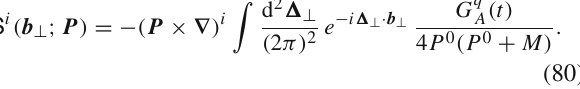
Fig. 16 Quarkspindistribution S ( b ⊥ ; P ) for P = ( 0 , 0 , P z ) usingthe multipole model (11) with parameters given in Table 1, see Eq. (80). a Distribution of the quark spin S in impact-parameter space for